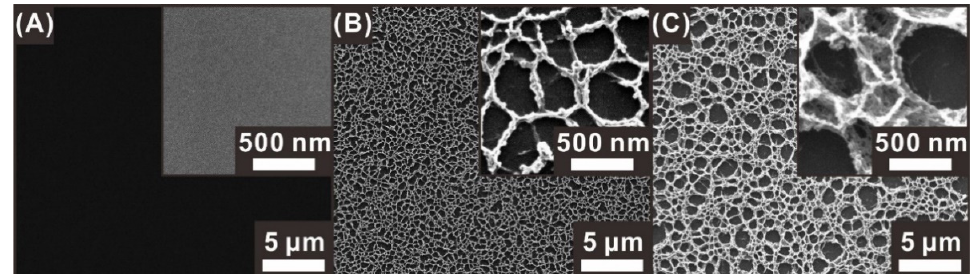
Figure 3. SEM images of carbon electrodes with different surface porosities formed depending on the O 2 -plasma-etching time: ( A ) bare carbon (BC) electrode (no plasma etching process), ( B ) porous carbon (PC) electrode (300 s plasma etching), and ( C ) HPC electrode (900 s plasma etching).